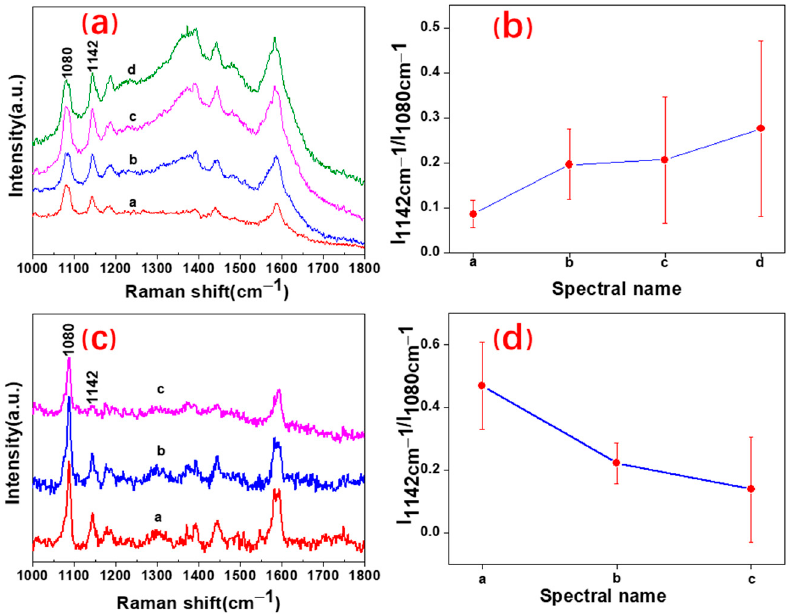
Figure 3. SERS spectrum of plasma-driven photocatalysis based on spherical silver nanoarrays: ( a ) SERS spectrum of PATP photocatalysis generating DMAB; ( b ) changes of the integrated peak intensity ratio of 1142 and 1080 cm − 1 vibrations corresponding to each spectral line in ( a ); ( c ) SERS spectrum of DMAB reverse reaction generating PATP; and ( d ) changes of the integrated peak intensity ratio of 1142 and 1080 cm − 1 vibrations corresponding to each spectral line in ( c ).